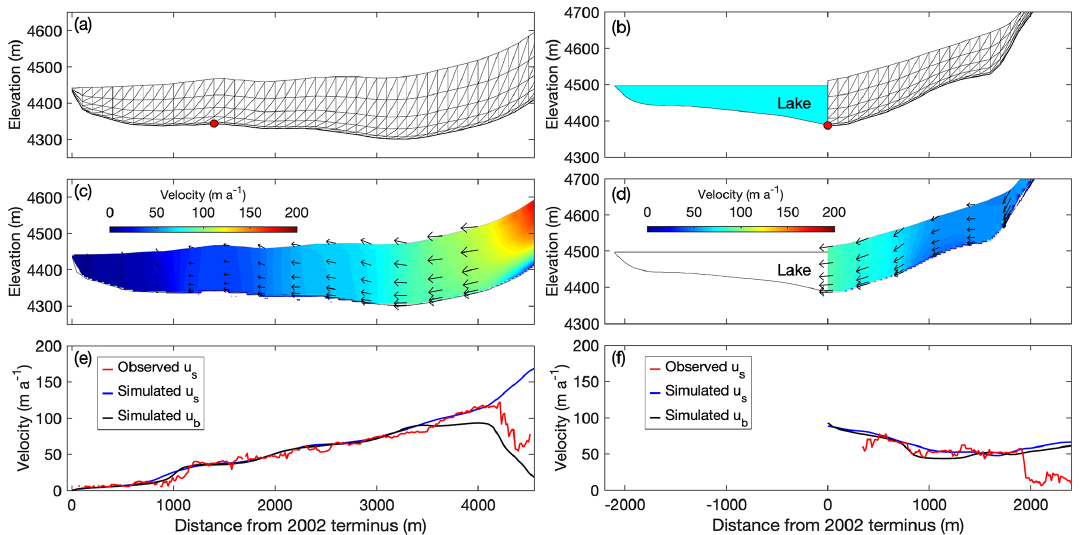
Figure 5. Ice flow simulations in longitudinal cross sections of Thorthormi (a, c, e) and Lugge (b, d, f) glaciers, with the present geometries of the glaciers employed in the models. (a, b) Finite element meshes used for the simulations, with red markers indicating the bedrock elevation based on a bathymetric survey. The light blue shading in (b) indicates Lugge glacial lake. Simulated (c, d) two-dimensional flow vectors (magnitude and direction) and (e, f) horizontal components of the flow velocity. The blue and black curves are the simulated surface ( u s ) and basal velocities ( u b ), respectively. The red curves are the observed surface flow velocities for 2002–2010.